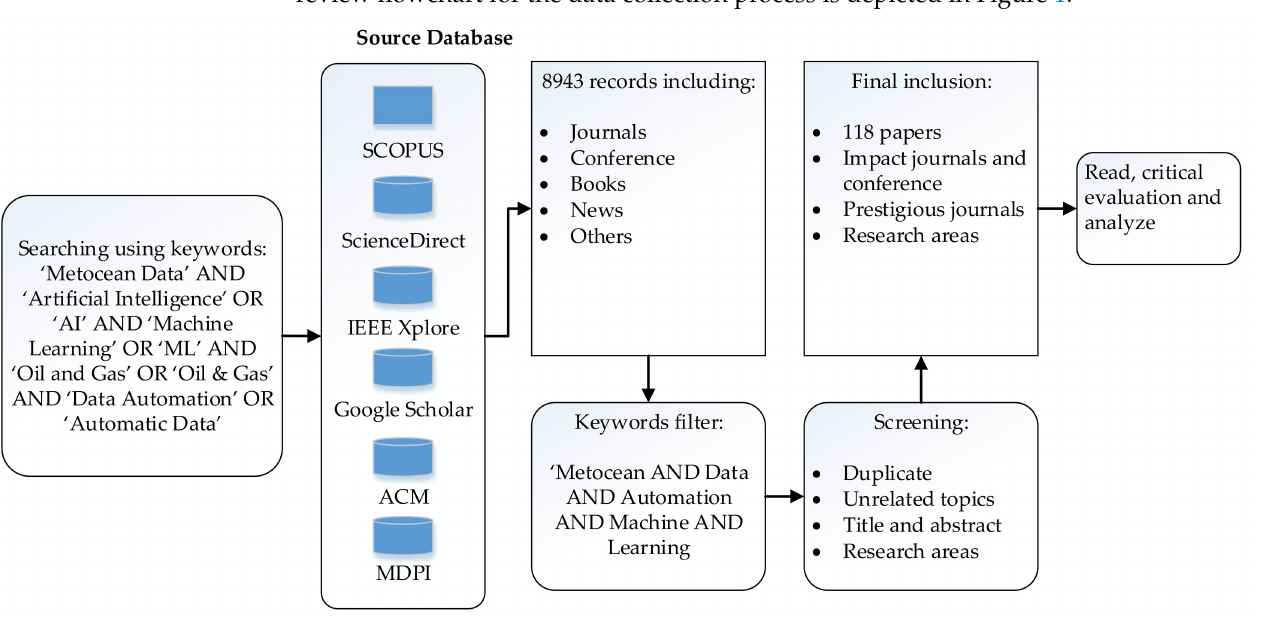
Figure 1. Flowchart for the data collection process.